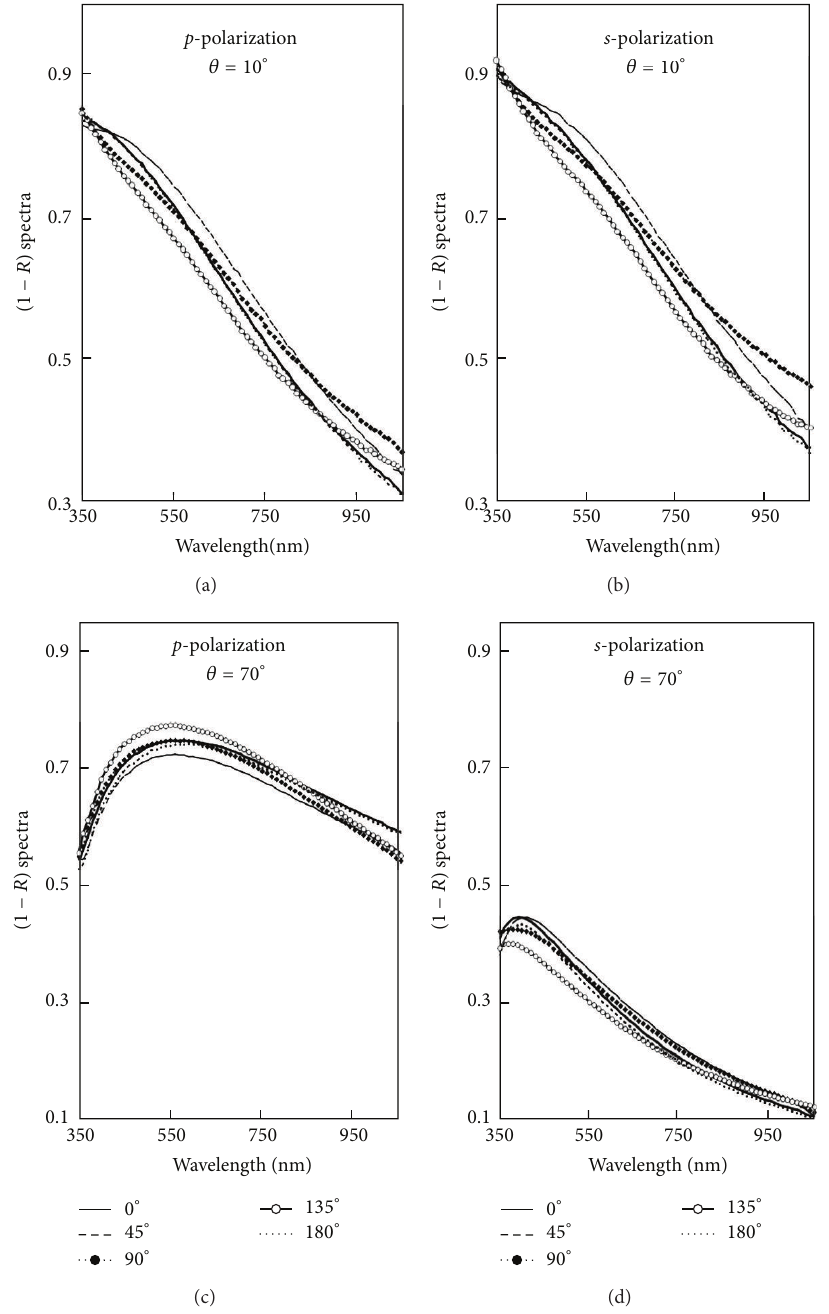
Figure 4: (1−𝑅) spectra of Ag chiral pentagon thin film obtained at two different incident angles (𝜃) and different azimuthal angles. ((a) and (b)) 𝜃 = 10 ∘ , 𝑝 - and 𝑠 -polarizations, respectively; ((c) and (d)) 𝜃 = 70 ∘ , 𝑝 - and 𝑠 -polarizations, respectively.